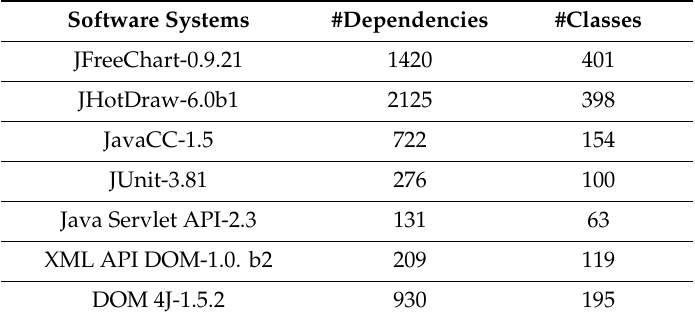
Table 2. Description of test